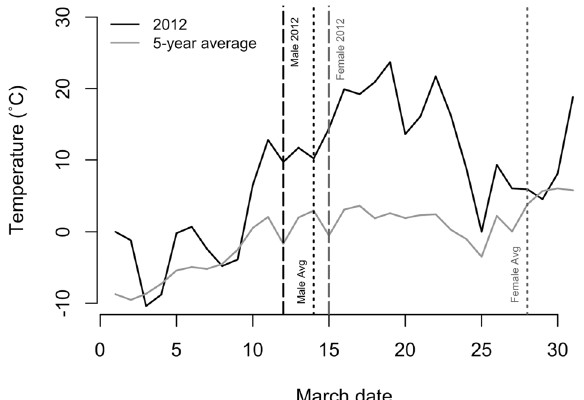
Figure 1. Daily maximum March temperatures (°C) in 2012 (black) compared to the 5-year average (2010– 2014; grey) in Winnipeg, Canada. In 2012, male (black dashed line) Richardson’s ground squirrels ( Urocitellus richardsonii ) at the Assiniboine Park Zoo in Winnipeg, Canada began to emerge from hibernacula only 3 days before females (grey dashed line), compared to 5-year average male (black dotted line) and female (grey dotted line)